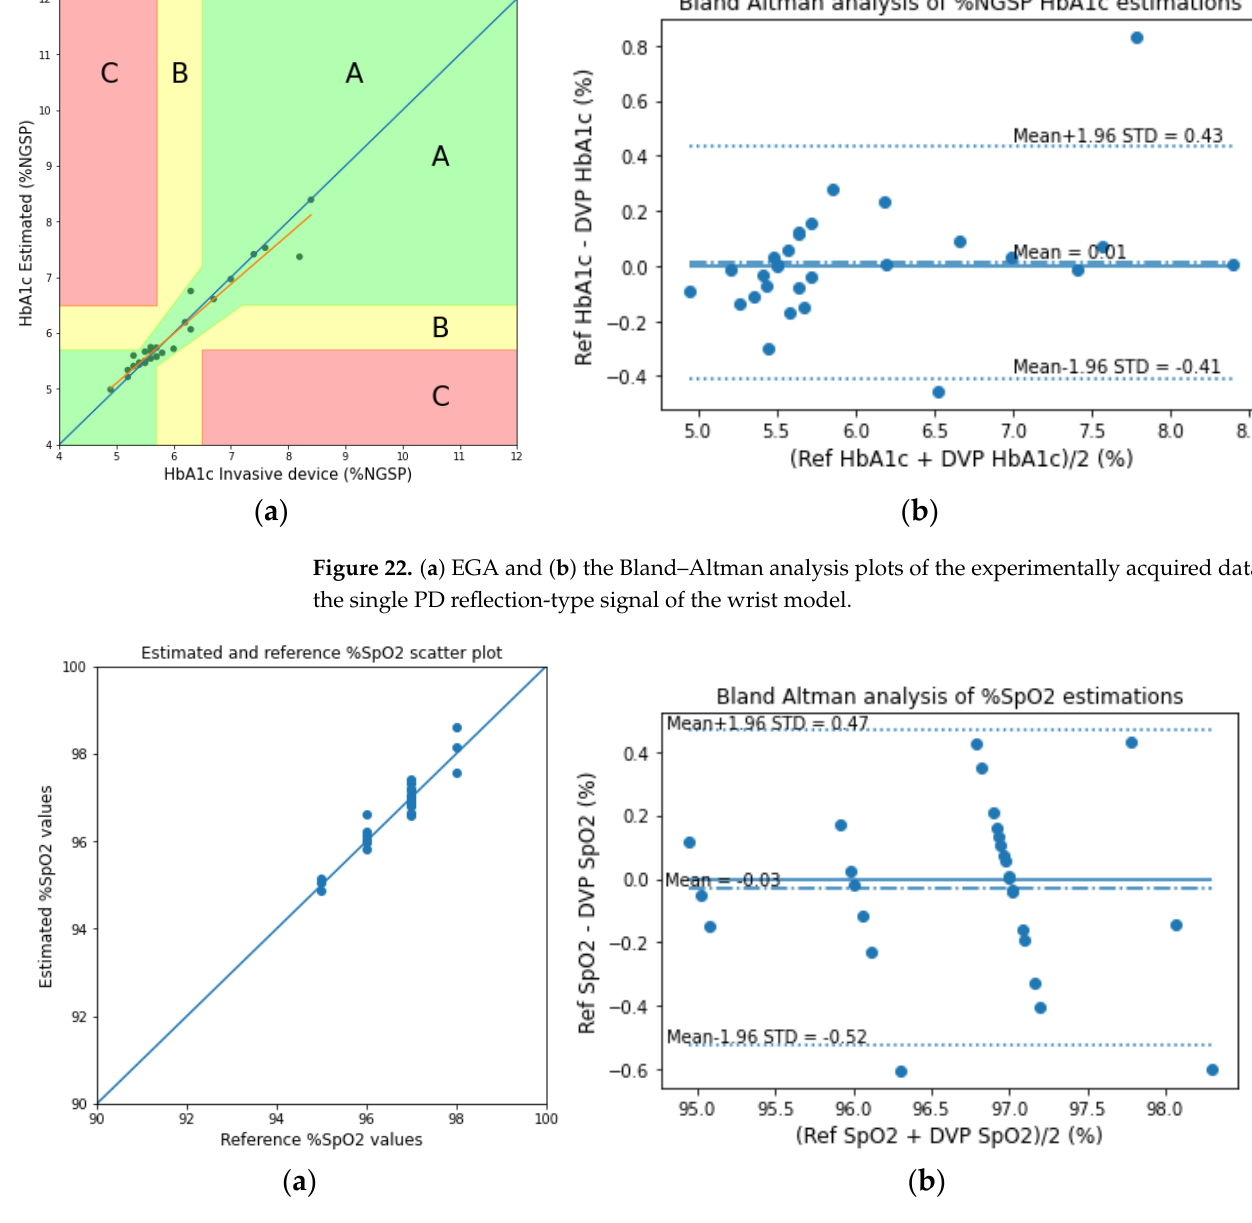
analysis plot of the experimentally acquired data for the single PD reflection-type signal of the wrist